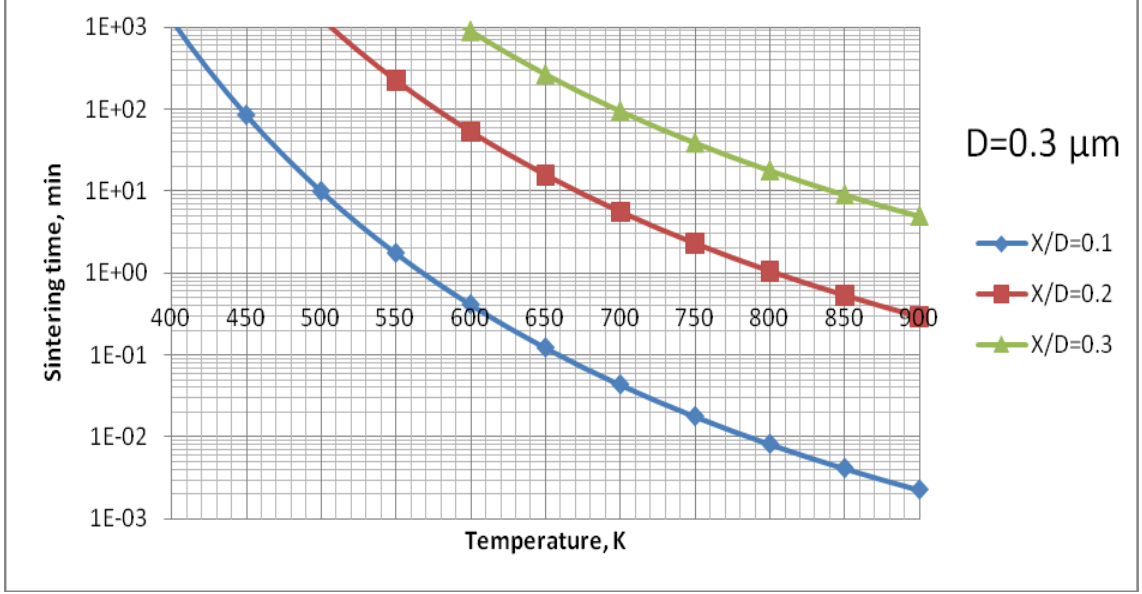
Figure 14. Sintering time of HA particles having an initial diameter of 0.3 µm to reach the necks diameter ranging from X/D = 0 to X/D = 0.1; 0.2 or 0.3 vs. temperature for surface diffusion mechanism of